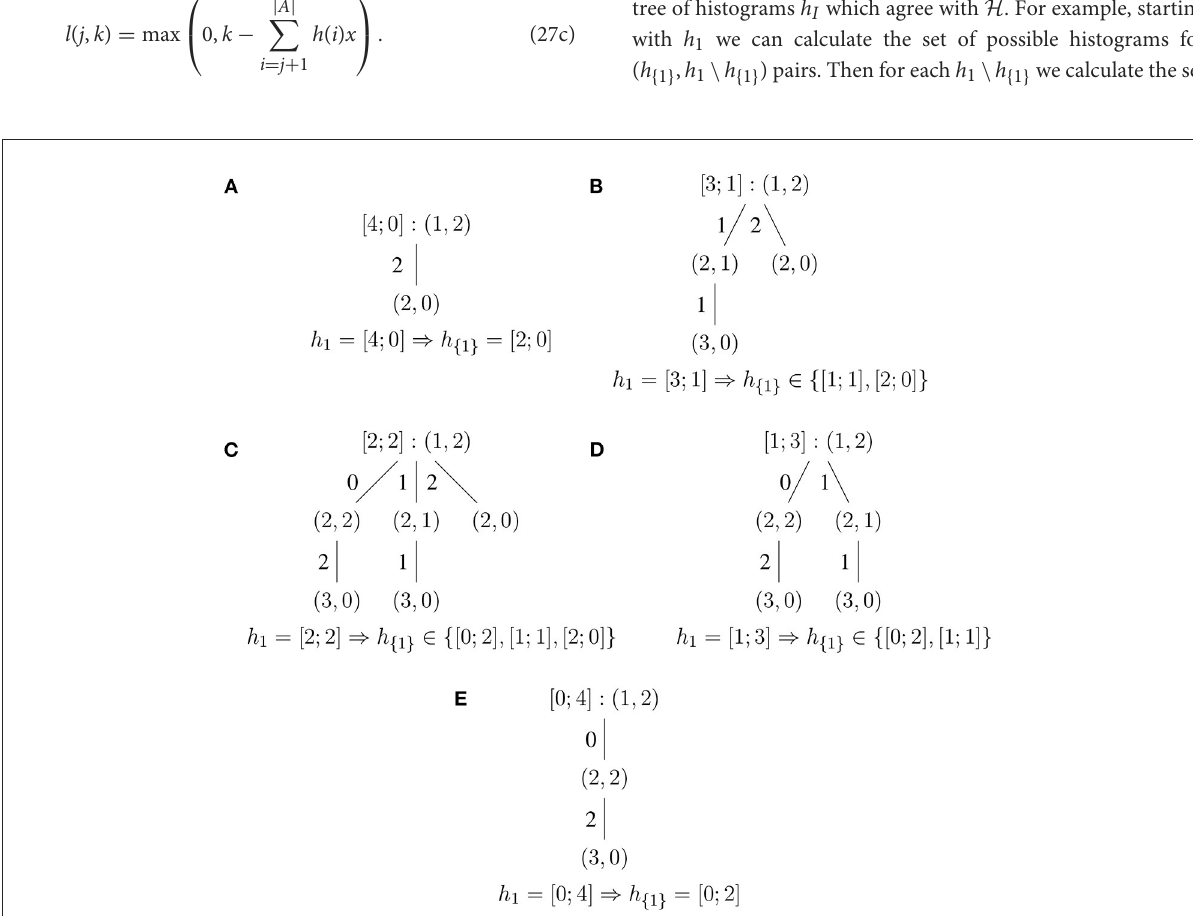
FIGURE2 Recursive evaluation of Equation (27). (A–E) corresponds to Equations (28a–28e). The nodes are the ( j , k ) pair, j is the index of the following histogram value, and the branch number its value. k is the number of values still to be decided. The count of leave-values gives the value of κ .